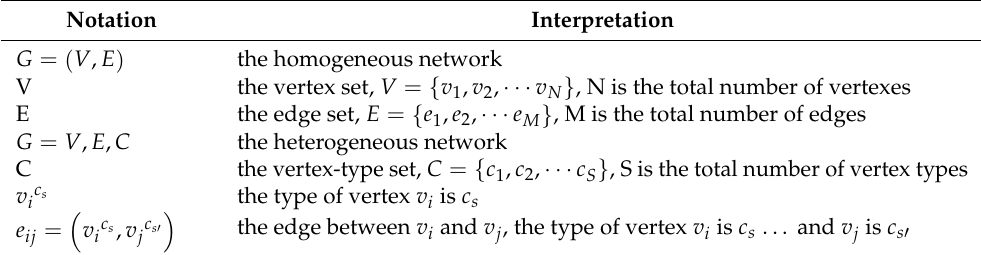
Table 1. The notations and their